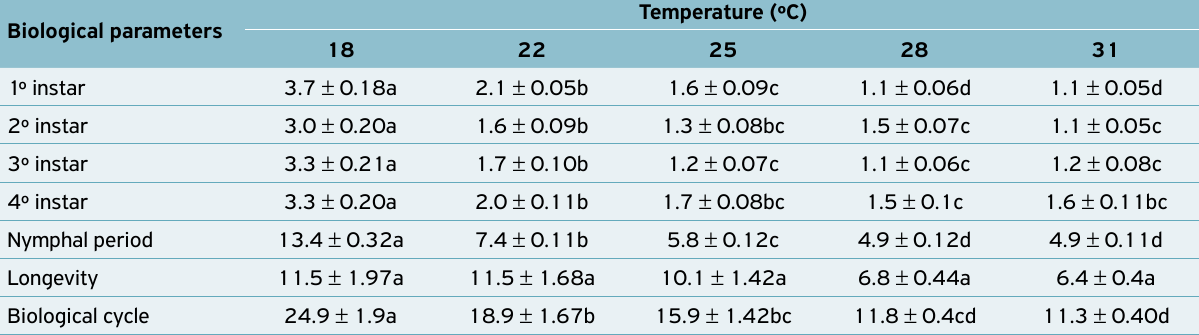
Table 1. Mean development time (days ± SE) of Aphis craccivora in Vigna unguiculata at different constant temperatures and a 12-hour photophase.